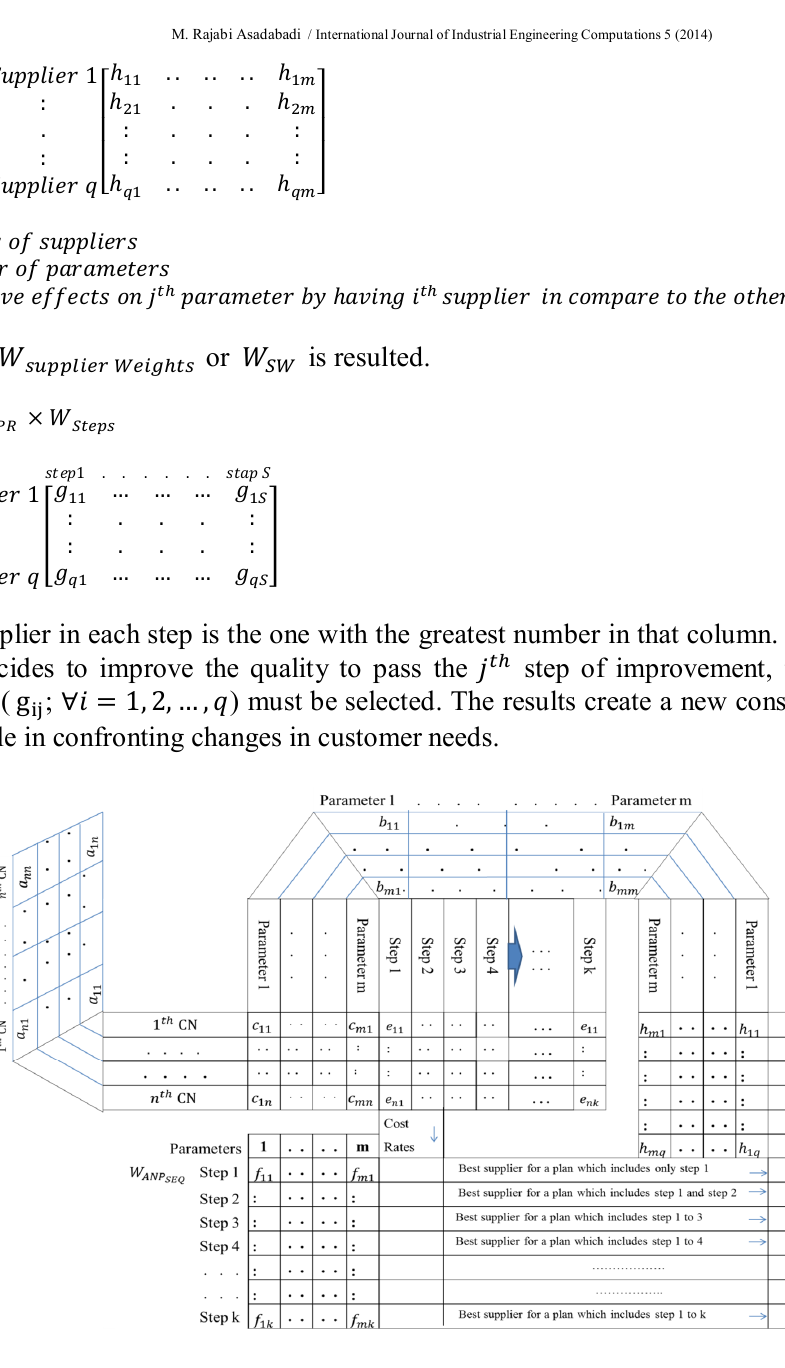
Fig. 1. HOQ in a hybrid-QFD for the Supplier Selection